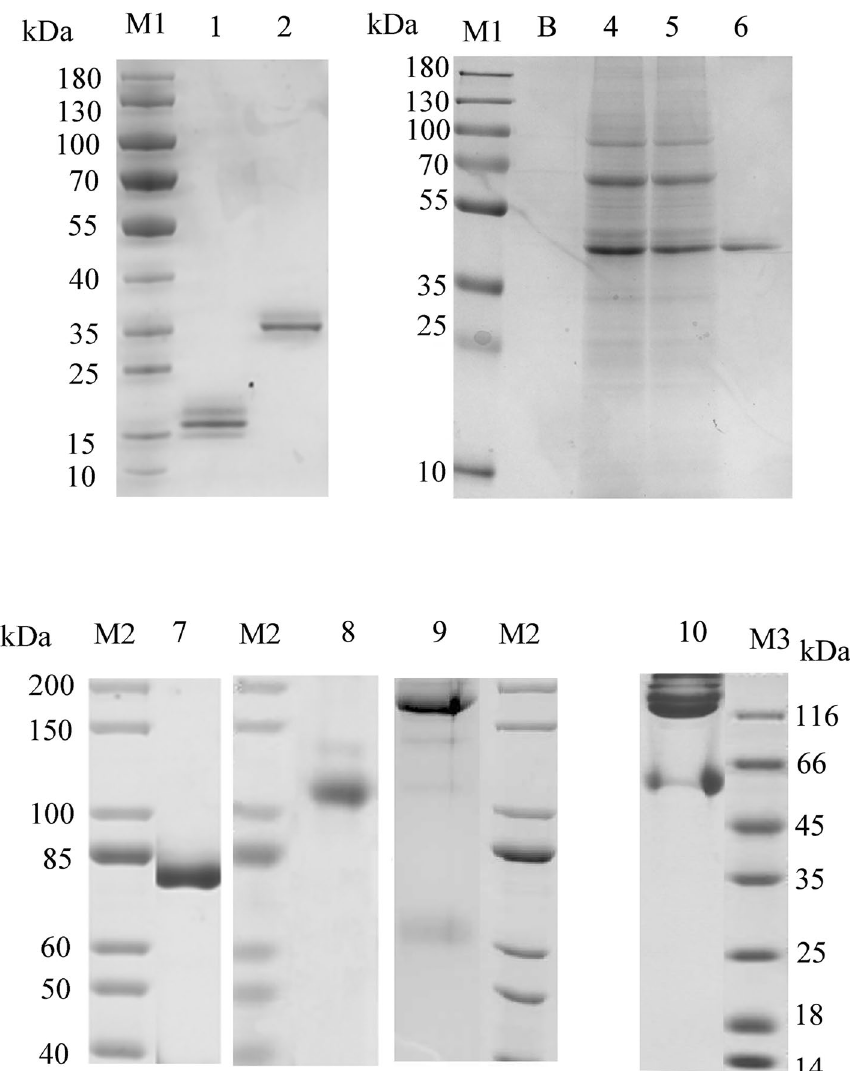
Figure 4. The SDS-PAGE gel of multiple VHH-B11 derived antibodies. The SDS–PAGE gel of multiple VHH-B11 derived antibodies. M1/M2/M3: the protein markers (Fermentas, USA). Lane 1: The VHH-B11 expressed by P. pastoris X33 ( pPICZα ); lane 2: The bivalent VHH-(G4S)3-VHH expressed by Pichia pastoris X33 ( pPICZα ); lane B: blank control; lane 4: the HEK293F culture medium superposition of the trivalent antibody VHH-(G4S)3-VHH-(G4S)3-VHH; lane 5: the Ni + affinity column flow-through of the trivalent antibody VHH- (G4S)3-VHH-(G4S)3-VHH; lane 6: the purified trivalent antibody VHH-(G4S)3-VHH-(G4S)3-VHH; lane7: Llama VHH-human IgG4 hinge linker-IgG4 Fc chimeric HcAb (VHH-Fc); lane 8: the tetravalent VHH-llama long linker-VHH-human IgG4 hinge linker-IgG4 Fc (VHH-VHH-Fc); lane 9: the tetravalent VHH-(G4S)3- VHH-human CH1-IgG4 hinge linker- IgG4 Fc chimeric Ab (VHH-VHH-CH1-Fc); lane 10: the tetravalent VHH-human IgG4 hinge linker-IgG4 Fc-llama long linker-VHH chimeric Ab